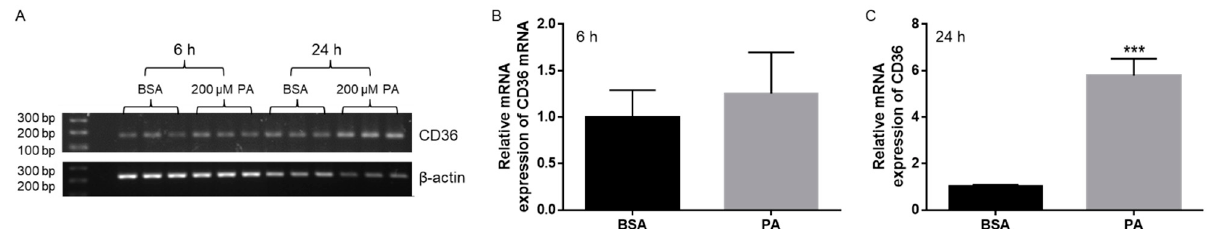
Figure 1. Relative mRNA expression of CD36 in N2a cells following treatment with 200 µ M PA or BSA for 6 h and 24 h using semi-quantitative RT-PCR. ( A ) Agarose gel images of CD36 and β -actin representative of three independent experiments. ( B ) Relative CD36 mRNA expression in N2a cells following treatment with BSA or PA for 6 h. ( C ) Relative CD36 mRNA expression in N2a cells following treatment with BSA or PA for 24 h. Data presented (mean ± SD) were representative of three independent experiments. Statistical analysis was performed using t -test. *** p < 0.001 vs. BSA control.